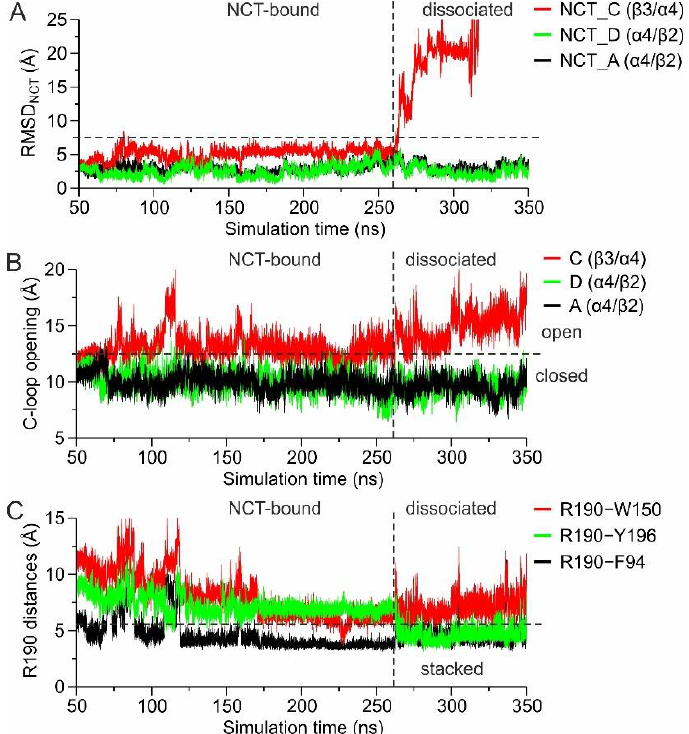
Figure 6. ( A ) Root-mean-square deviation (RMSD) of nicotine heavy atoms from the initial position at the three modeled interfaces of the pentameric (α4β2) 2 β3 subtype (Figure 5A), as a function of the simulation time. ( B ) The loop C distances (as defined in Figure 2C) of the three corresponding agonist-bound sites, as a function of simulation time. ( C ) Distance between Arg190 of β3(+) and the interacting aromatic residues that were found in the X-ray structure, as a function of simulation time. Plots were extracted from one of the three MD simulations that exhibited nicotine dissociation as illustrated in Figure 5C (see also Figures S8 and S9).